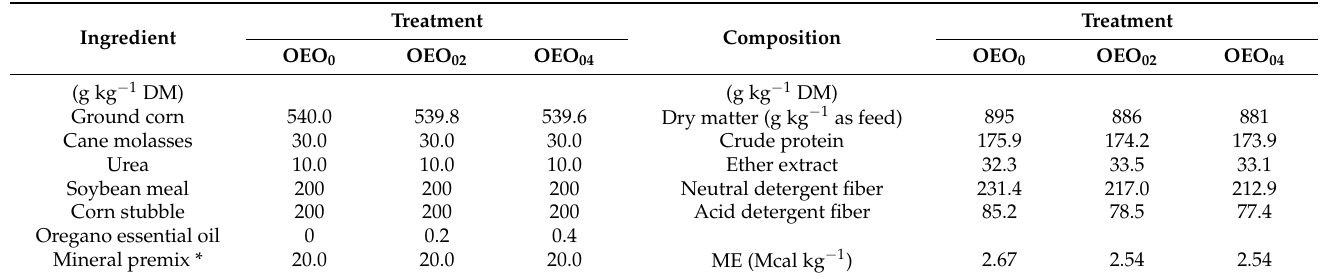
Table 1. Ingredients and chemical composition of the experimental